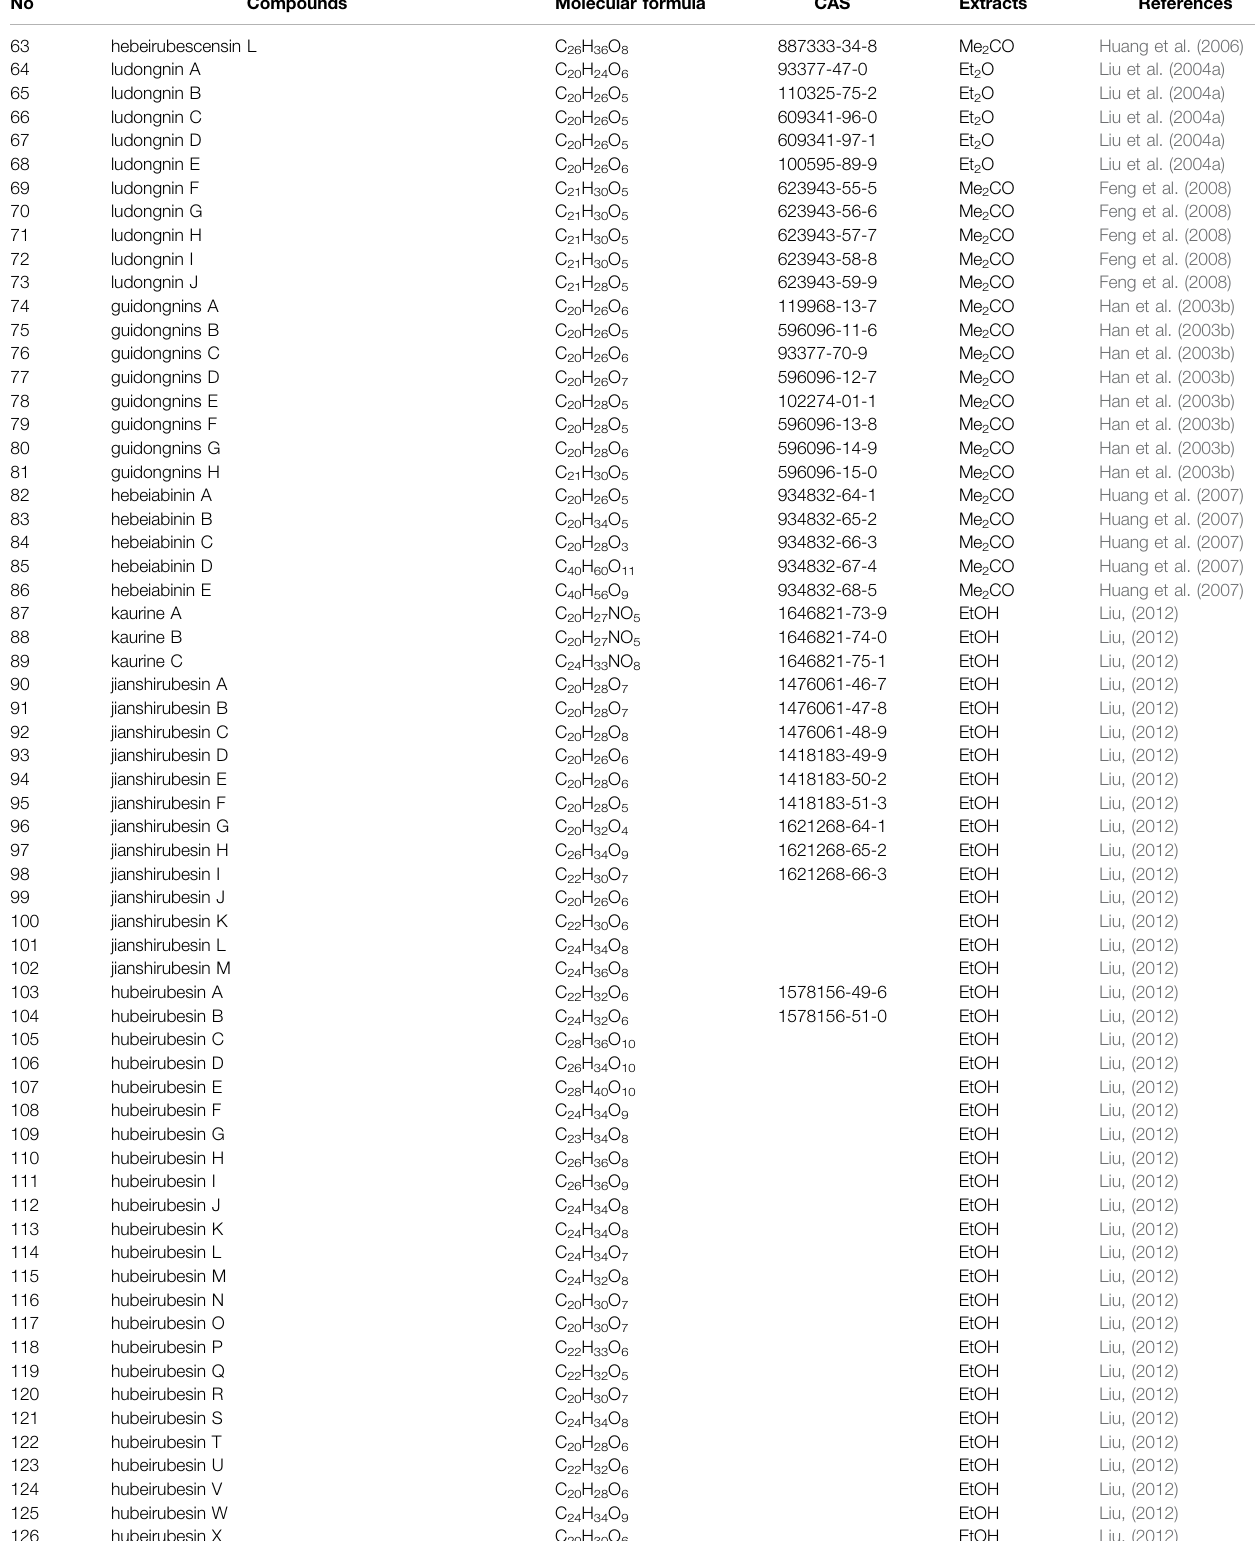
TABLE 2 | ( Continued ) The chemical constituents isolated from the I. rubescens